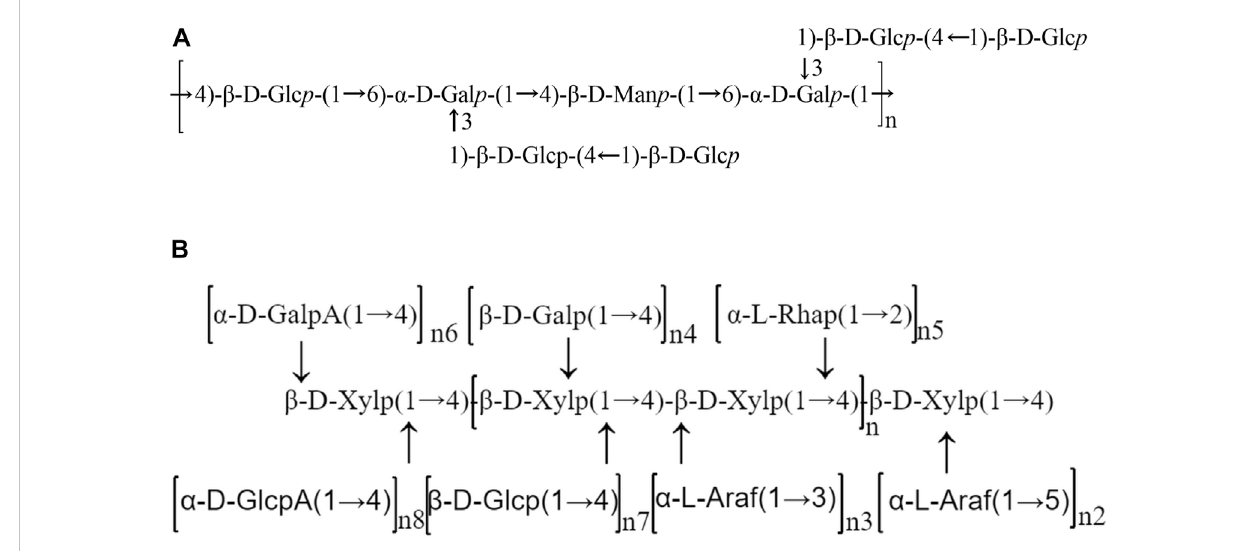
Schematic structures of Salvia miltiorrhiza polysaccharides. (A) Chemical structure of PSFP-W-1 (Wu et al. (2019)); (B) The possible structure model of HBPs (Zhao et al.